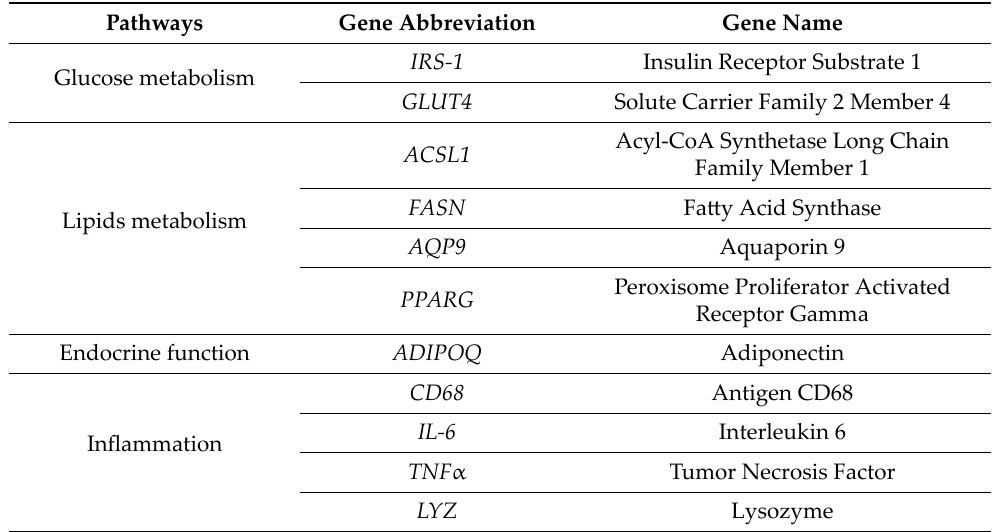
Table 1. Summary of candidate genes differentially expressed in subcutaneous adipose tissue among lean, obese and